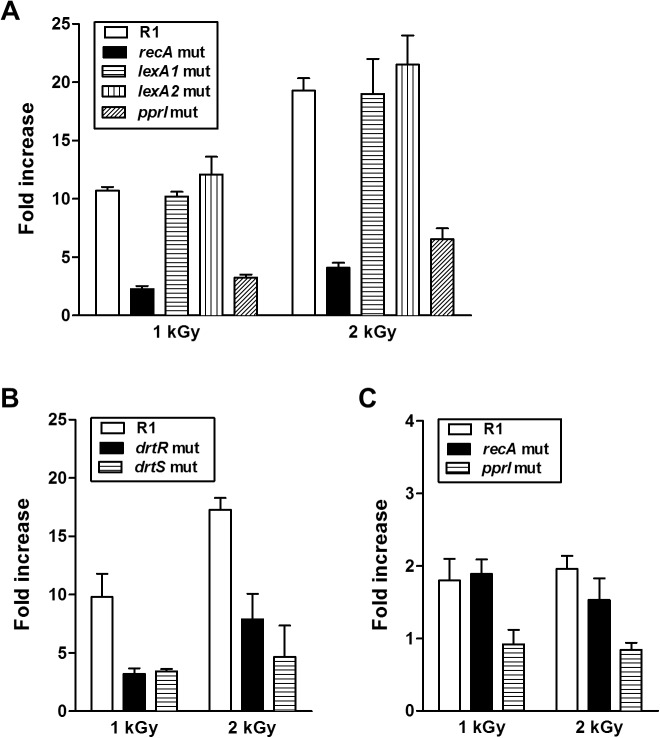
Expression profiles of dr0053 and drtR in mutant strains.Bacterial cultures were exposed to γ-radiation and allowed to recover for 1 h. After total RNA isolation, qRT-PCR analysis was performed to determine dr0053 (A and B) and drtR transcript levels (C). The fold increase in each strain was obtained by dividing the mRNA levels from the irradiated cells by that from the non-irradiated cells. Error bars indicate the standard deviations from three independent experiments performed in duplicate.